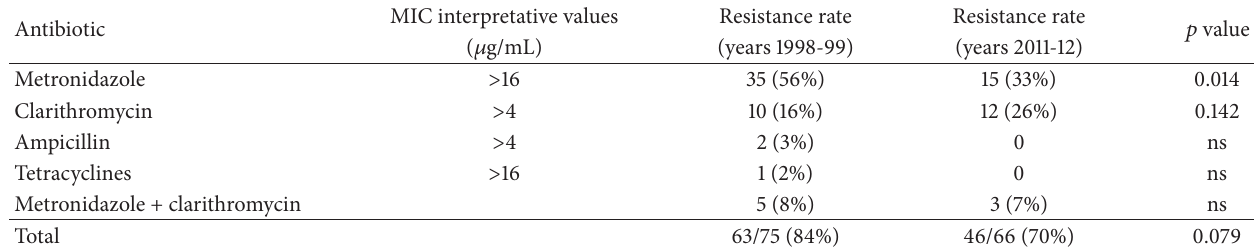
Table 3: Differences in antibiotic